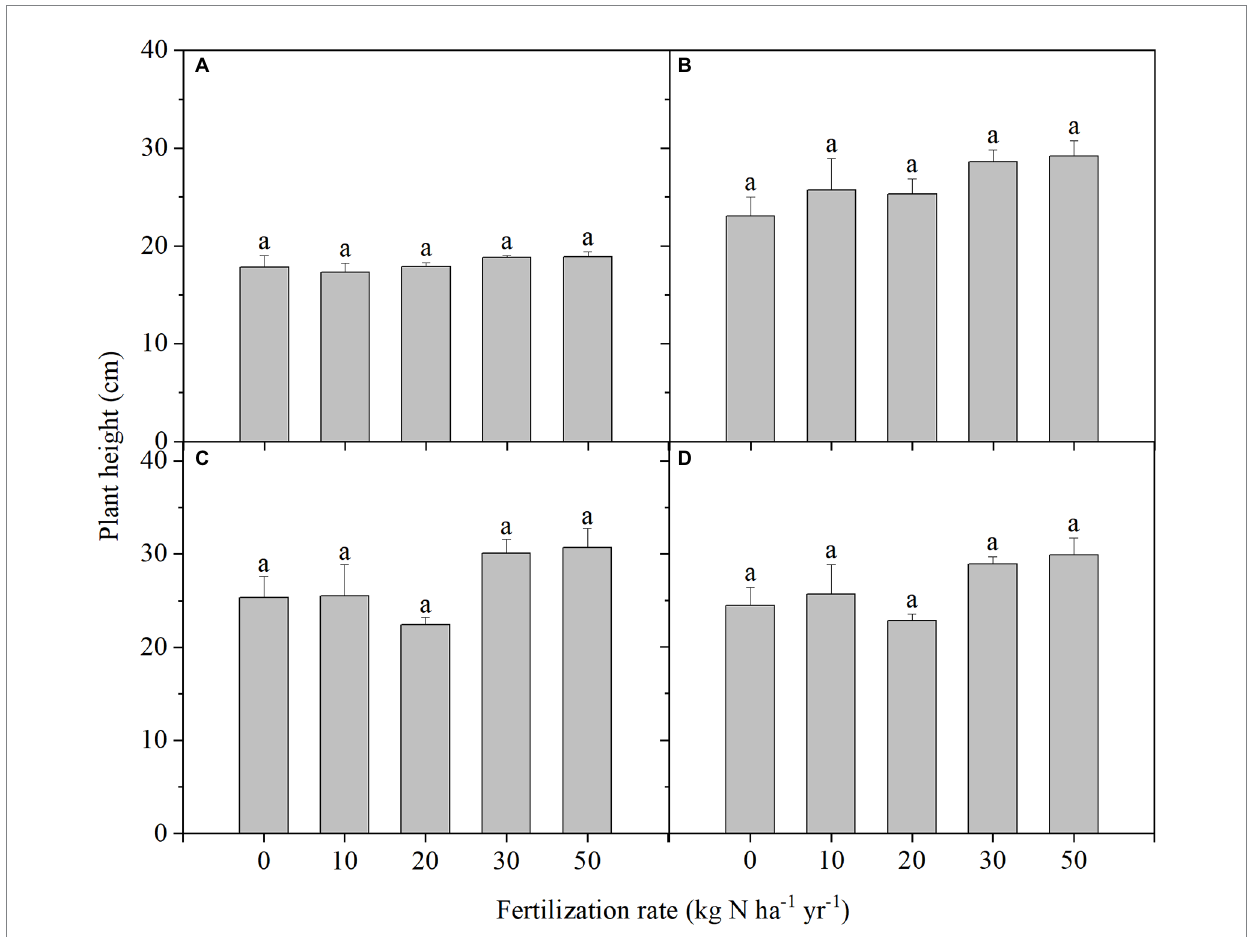
FIGURE 1 Plant heights in Stipa breviflora plants grown under different N addition rates at 30 days after sowing (DAS) (A) , 60 DAS (B) , 90 DAS (C) , and 120 DAS (D) . Each value is the mean of four replicates (+SD). Different lowercase letters indicate significant differences among the treatments at p <